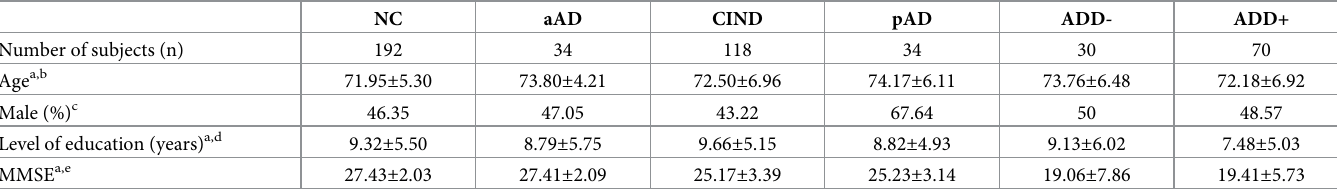
Values are expressed as mean ± standard deviation